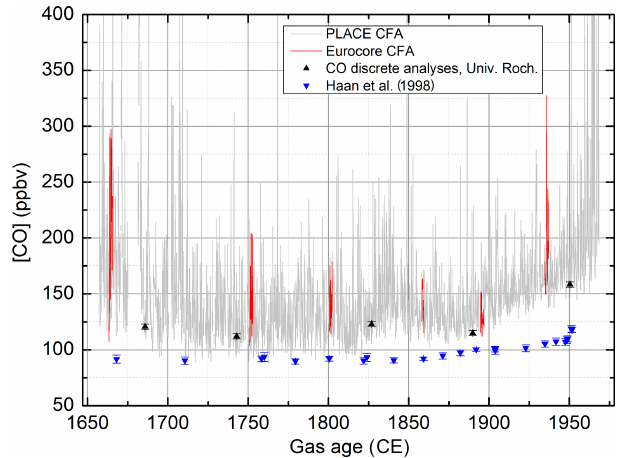
Figure 6. CO mixing ratio collected (i) along the PLACE ice core, showing the continuous IGE CFA record with the 5th percentile baseline (gray line) and the discrete dataset (black dot); and (ii) along the Eurocore archive, showing the historical Eurocore discrete CO data (blue dot; Haan et al., 1998) and the CFA-based dataset measured in 2019 at IGE